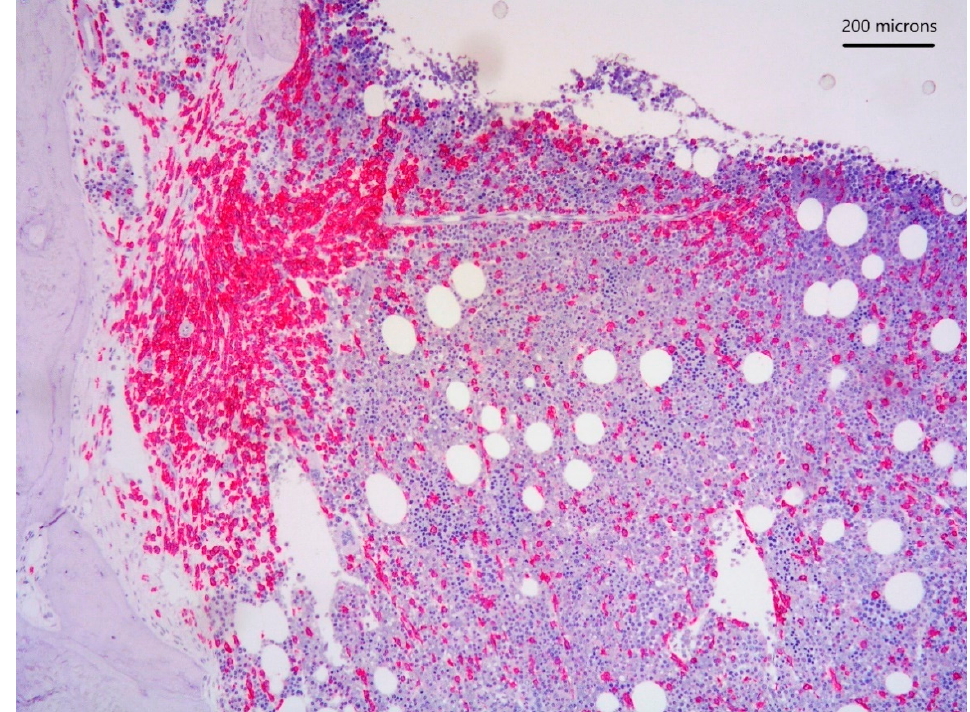
Figure 3. CD117 immunostain highlighting paratrabecular aggregates of spindle-shaped cells.